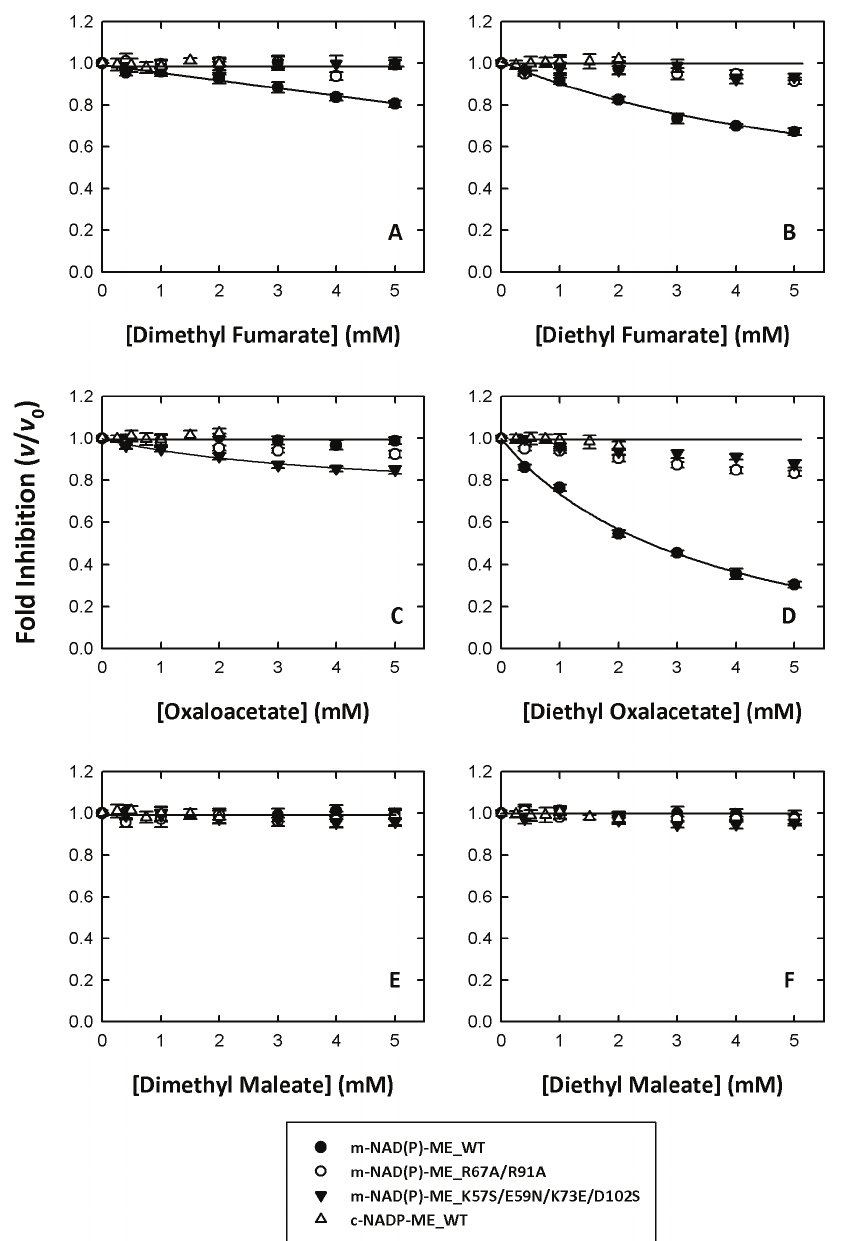
Figure 3. Allosteric inhibition of human m-NAD(P)-ME by fumarate and its analogs. (A) Dimethyl fumarate; (B) Diethyl fumarate; (C) Oxaloacetate; (D) Diethyl oxalacetate; (E) Dimethyl maleate; (F) Diethyl maleate. Closed circles, m-NAD(P)-ME; open circles, m-NAD(P)-ME_R67A/R91A; closed triangles, m-NAD(P)-ME_K57S/E59N/K73E/D102S; open triangles, c-NADP-ME. The specific activities of the m-NADP-(P)-ME WT, R67A/R91A, K57S/E59N/K73E/D102S and c-NADP-ME WT were approximately 0.1, 0.005, 0.02 and 0.08 m mol/min, respectively, and the final enzyme concentration in an individual assay was 20, 400, 100, and 25 ng/ m l, respectively. The v and v 0 represented the enzyme activity in the presence and absence of fumarate analogs,